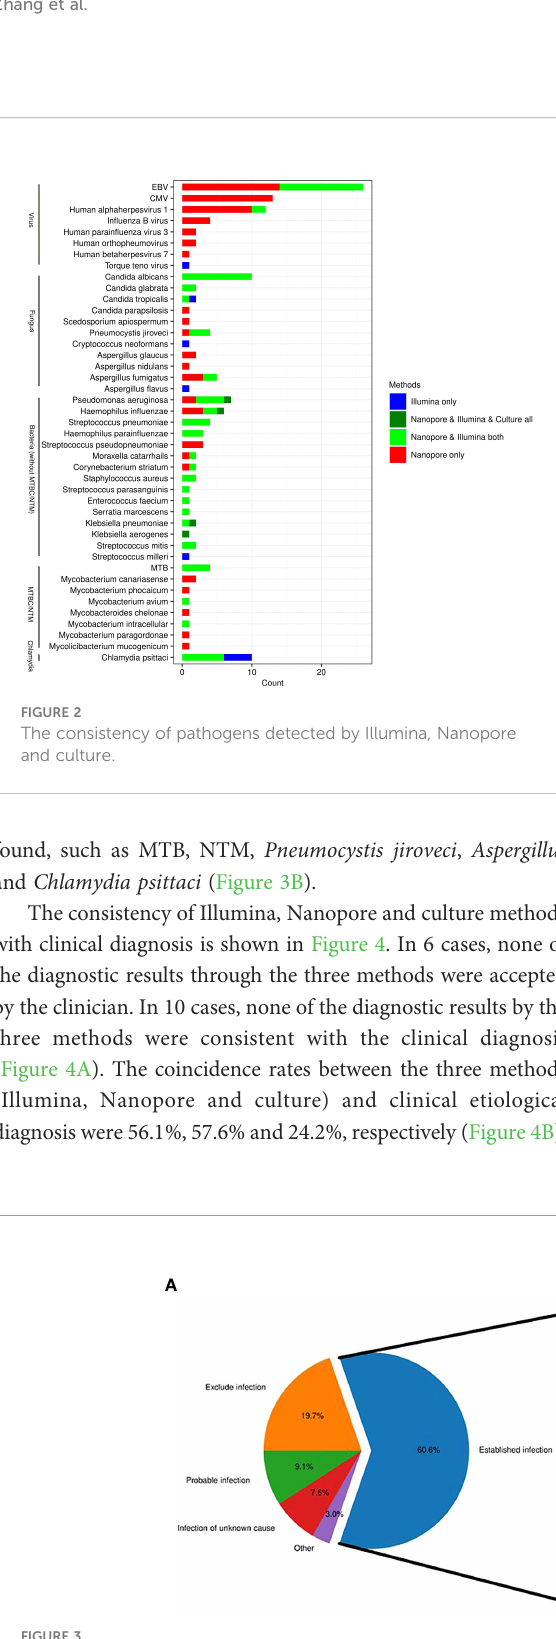
FIGURE 3 Distribution of infection diagnosis in suspected CAP patients. (A) , Diagnostic distribution and etiological classi fi cation of infection established in patients with suspected CAP. (B) , Speci fi c pathogens detected in bronchial alveolar lavage fl uid from patients with established